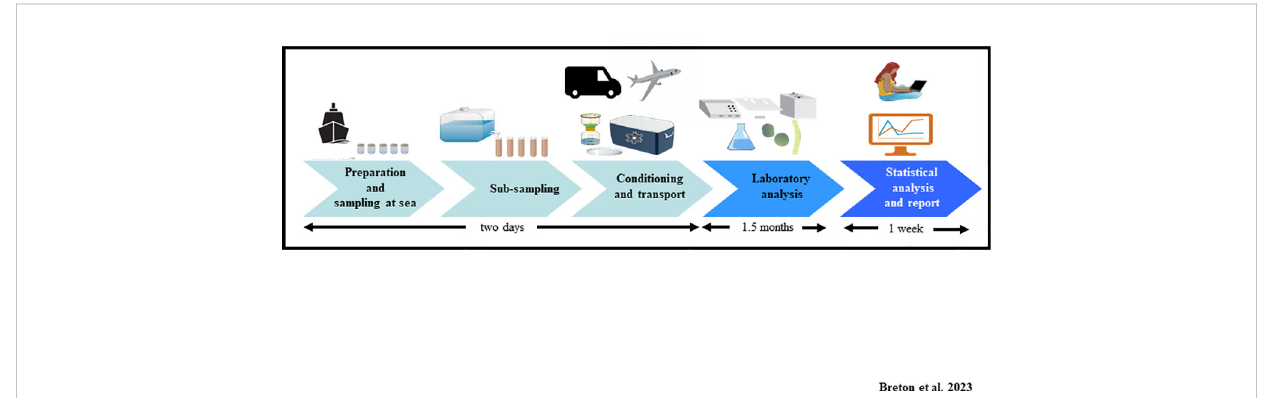
FIGURE 5 Scheme of the different steps of the annual ILC exercises implemented by the SOMLIT network since 2001.